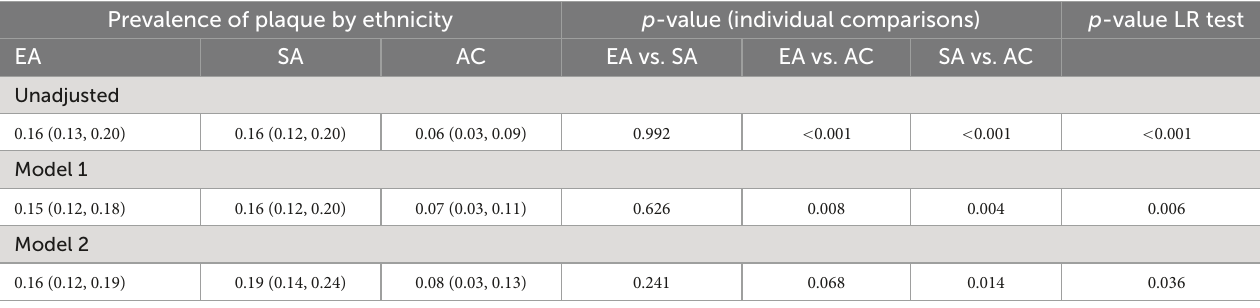
TABLE 2 Marginal probabilities of having any plaques by ethnicity with and without adjustment for risk factors. Prevalence of plaque by ethnicity p -value (individual comparisons) p -value LR